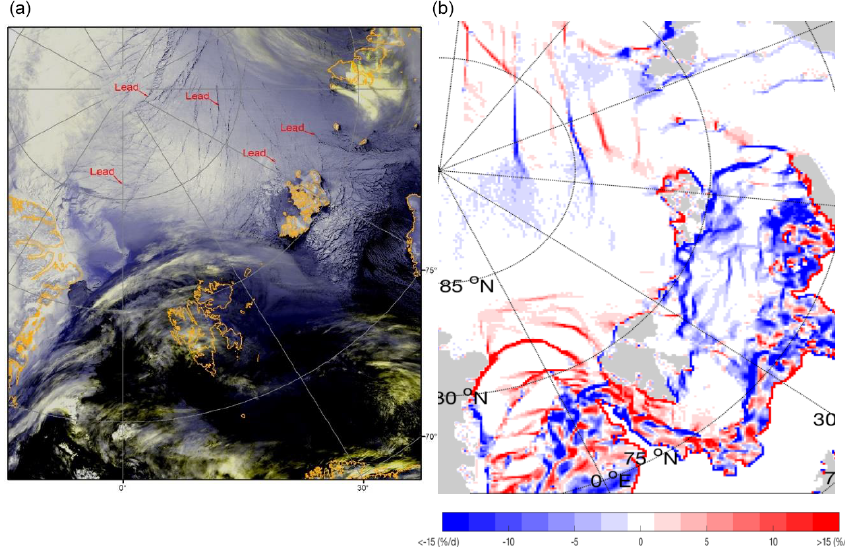
Figure 9. (a) Sea ice lead structures in data taken on 5 March 2020 from infrared channel 5 of the NOAA-20 satellite with the highest possible resolution (375m), with the identification of leads. These data were obtained using the VIIRS instrument (Visible/Infrared Imager Radiometer Suite) installed onboard the NOAA-20 satellite. (b) Daily mean sea ice divergence (%d − 1 ) on 5 March 2020 in the RASM simulation. No data manipulation was done except for daily